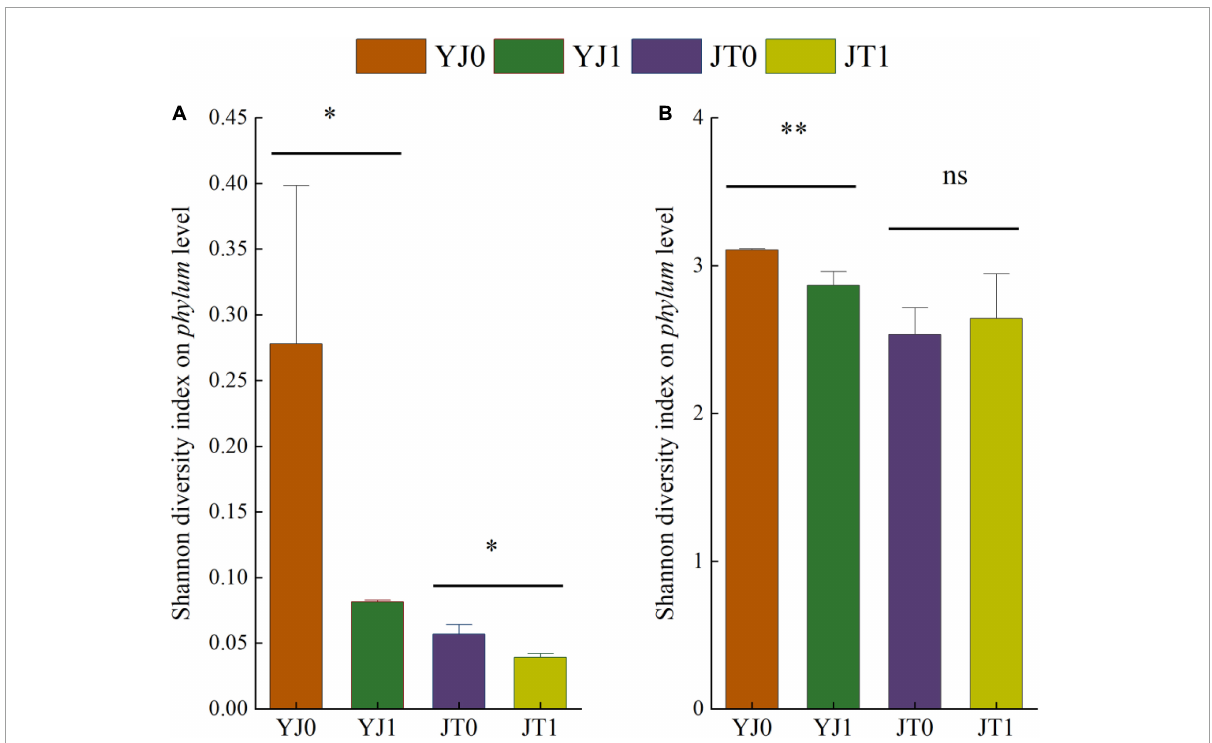
FIGURE1 Diversity indices (Shannon) of bacterial community (A,B) at phylum level in ensiled sorghum at flowering and maturing stage. All data represented means ± SD. ∗ and ∗∗ indicated the level of significance at p < 0.05 and p < 0.01; ns indicated non-significance. YJ0, Yajin without bloom; YJ1, Yajin with bloom; JT0, Jintian without bloom; JT1, Jintian with